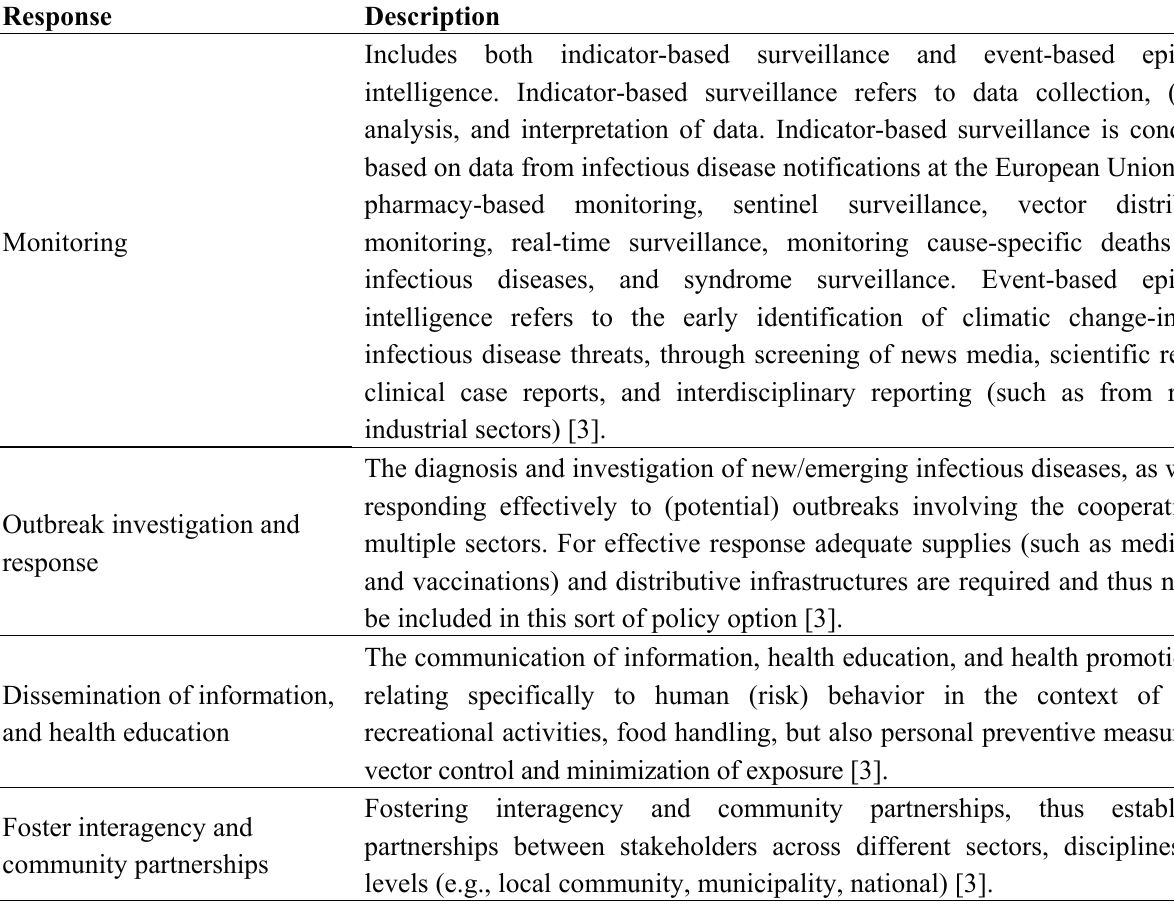
Table 1. Descriptions/definitions of the responses to climate change-induced infectious disease risk used in the